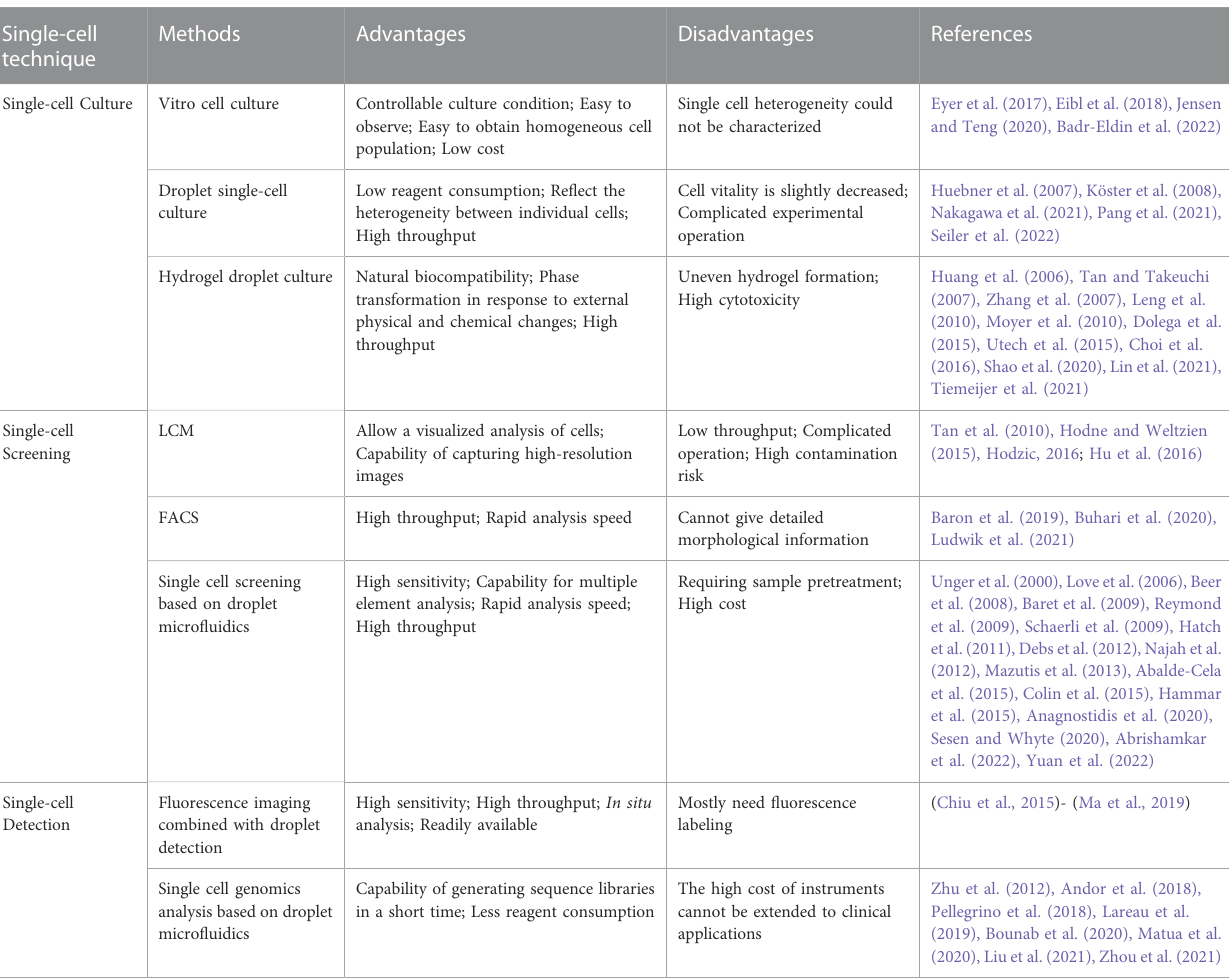
TABLE 1 Comparison of advantages and disadvantages of single-cell